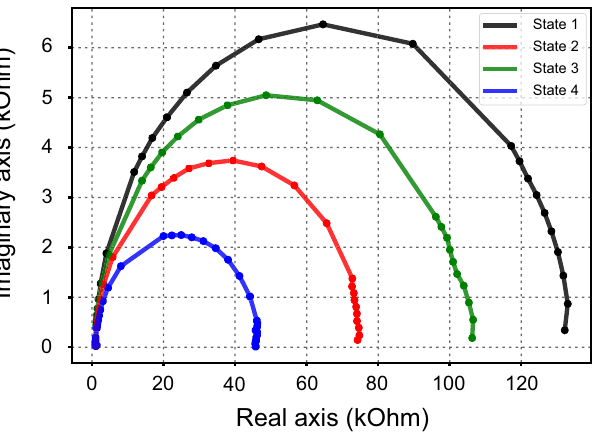
Figure 4. A representation in a Nyquist plot can be useful for identifying the equivalent electrical model corresponding to each technology. It is also useful for calculating capacitance in devices that exhibit RC behaviour. In this type of plot diffusive phenomena are exacerbated and can be easily identified, which is important for devices which have mobile ions in them. Here a device with 4 resistive states is presented, with data experimentally received by following the measurement protocol, applied to a device with layered MIM structure, as shown in Fig.